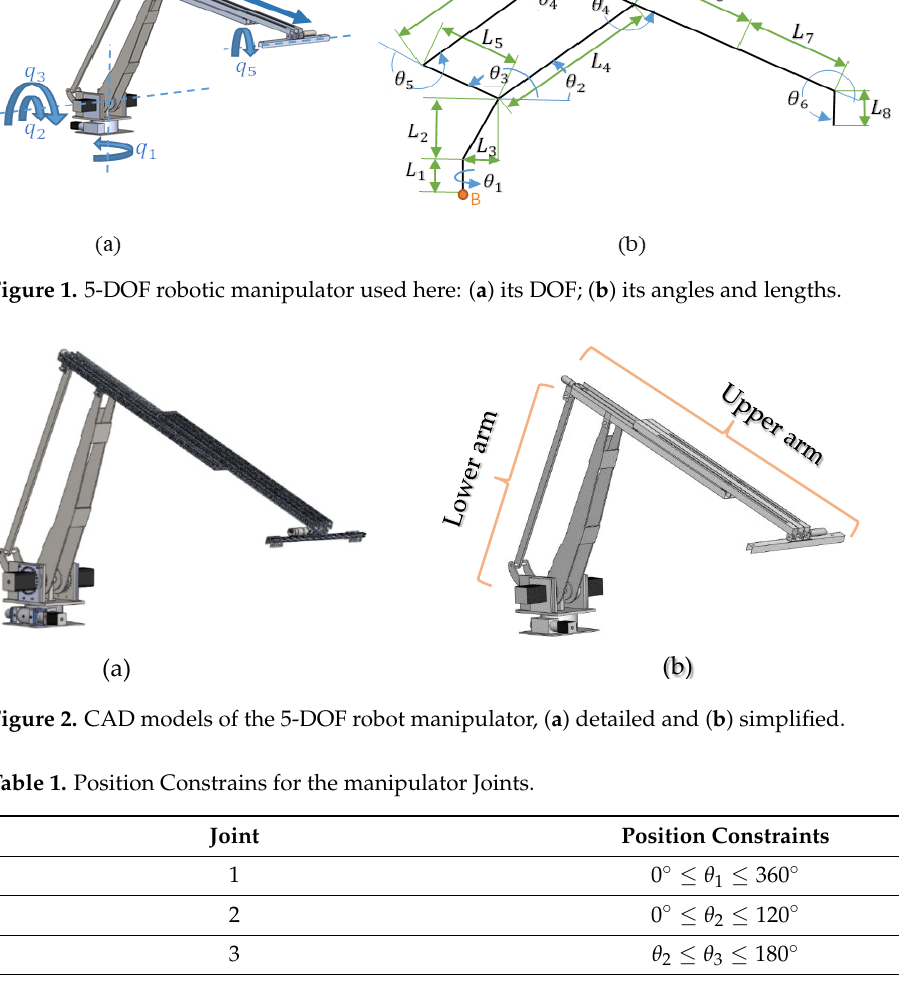
Figure 1. 5-DOF robotic manipulator used here: ( a ) its DOF; ( b ) its angles and lengths.